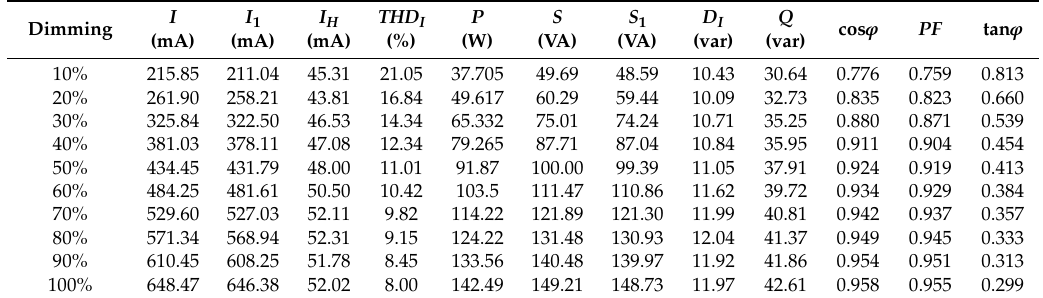
Table 9. Summary of measured values of electrical parameters of the LED3 luminaire.